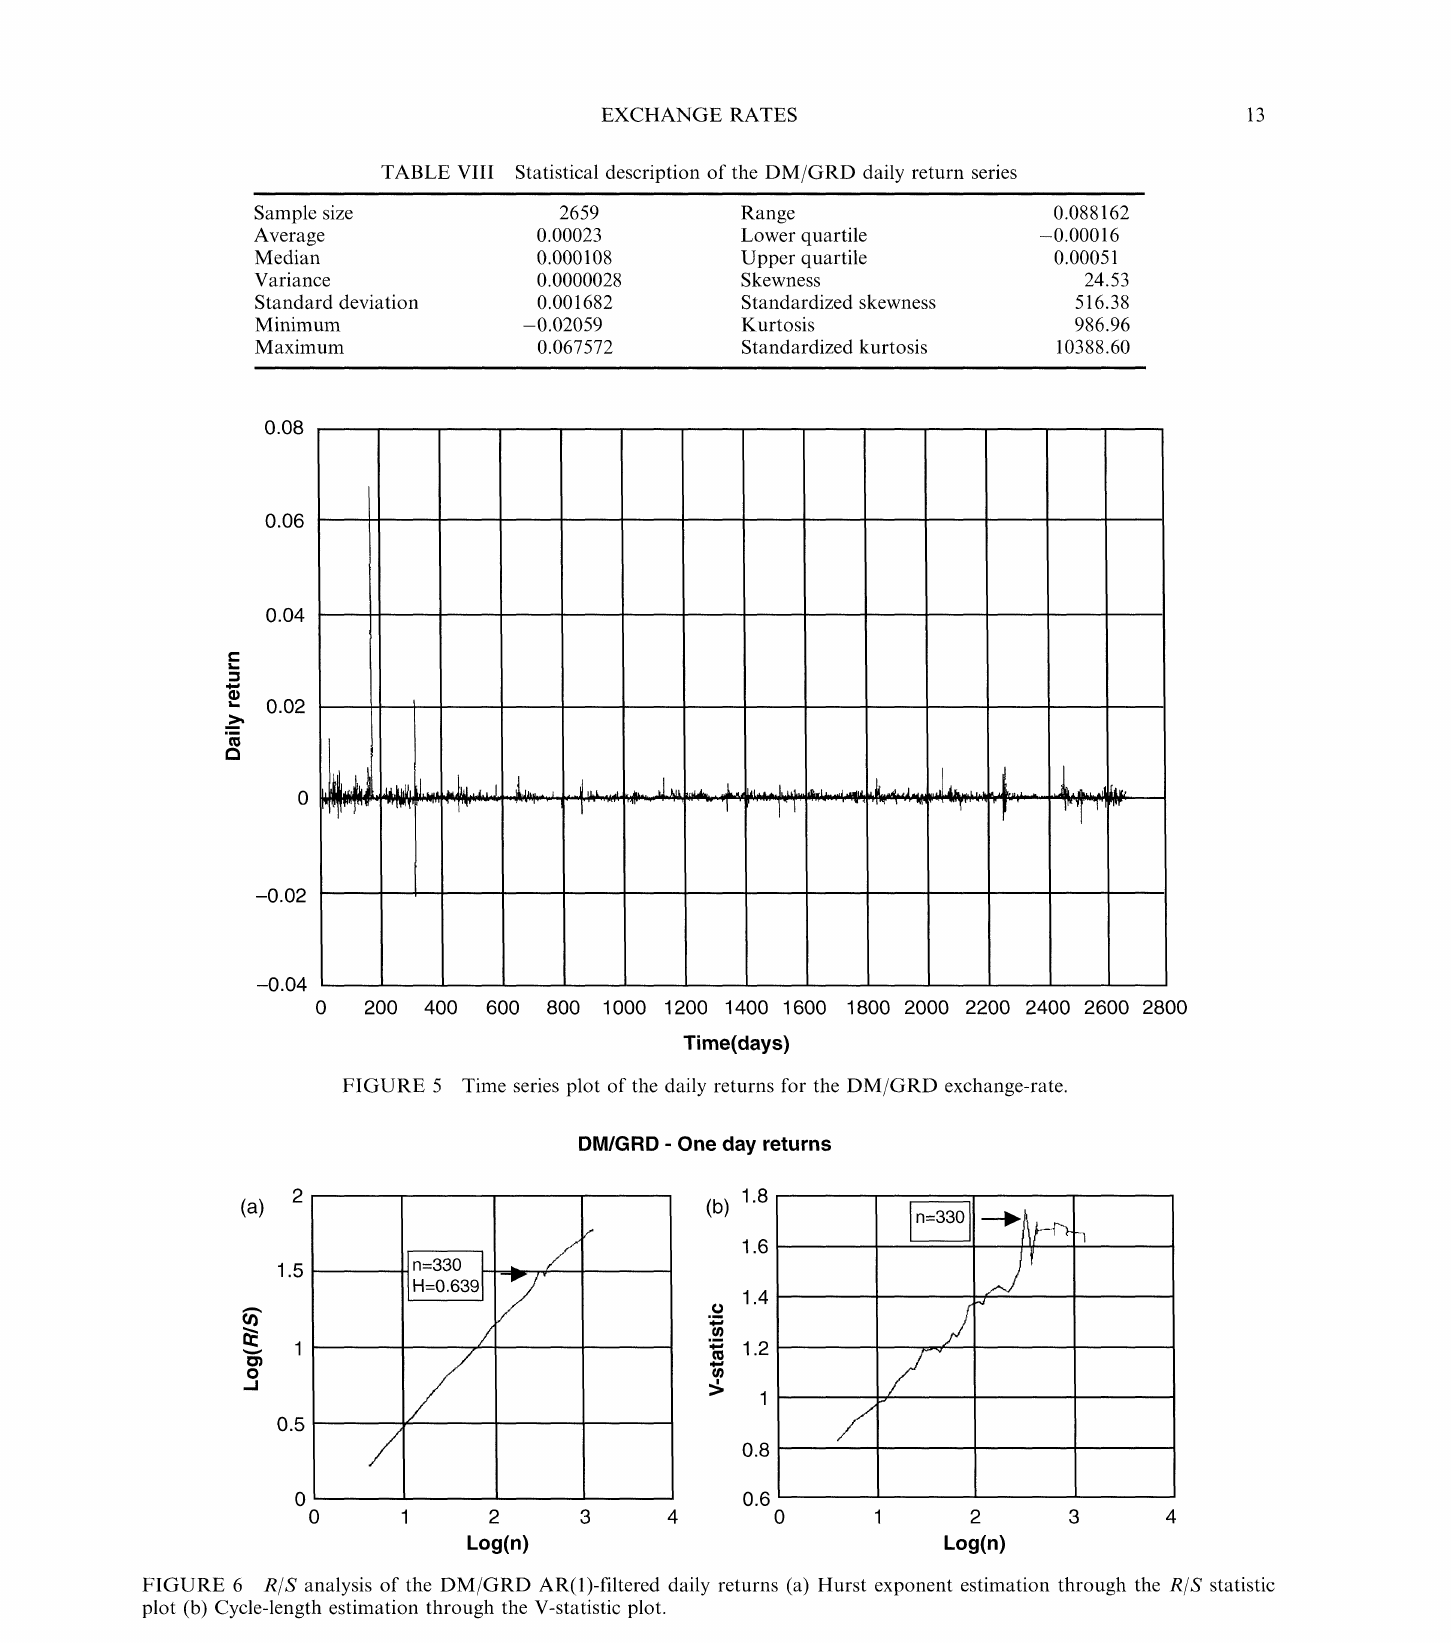
FIGURE 6 R/S analysis of the DM/GRD AR(1)-filtered daily returns (a) Hurst exponent estimation through the R/S statistic plot (b) Cycle-length estimation through the V-statistic